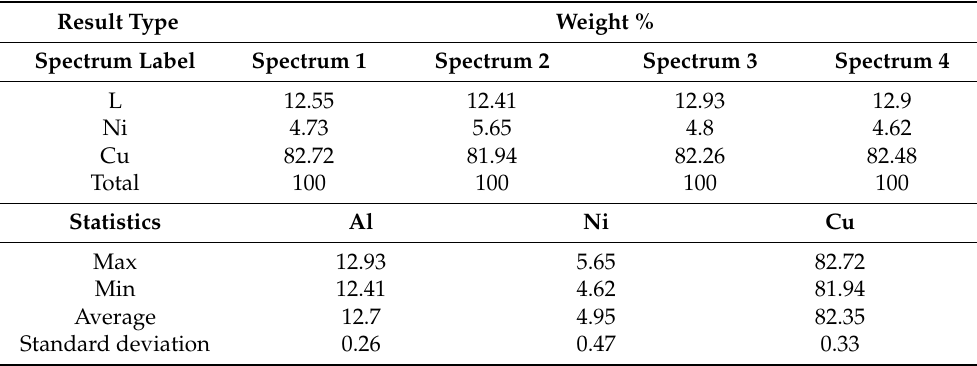
Figure 7. SEM for EDS of the sample after ( a ) 420 min of cavitation exposure of as-cast state (L) and ( b ) quenching and 420 min of cavitation exposure (K2). Table 2. EDS analysis of as-cast state (L).